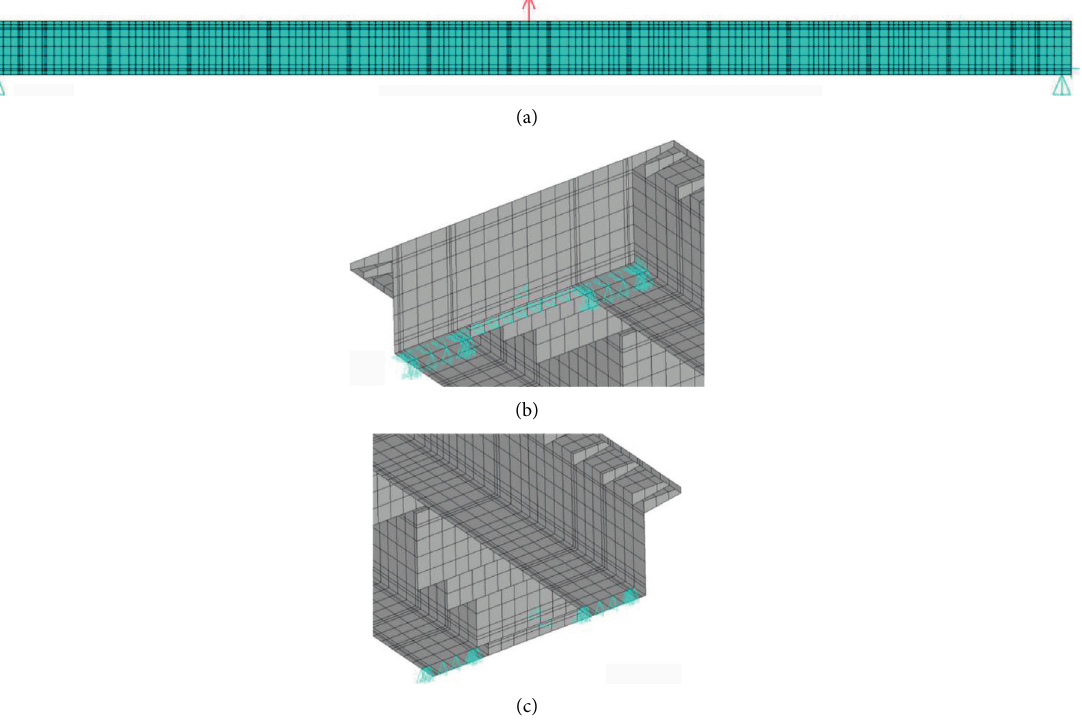
Figure 10: Structural FEM model of bridge girder: (a) elevation view; (b) north bearing; and (c) south bearing.